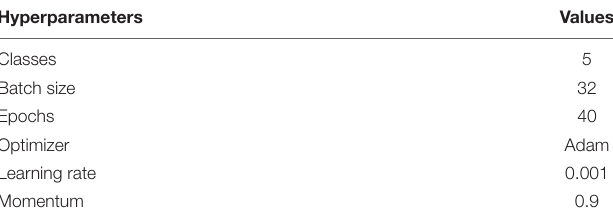
TABLE 3 | Hyperparameter settings.